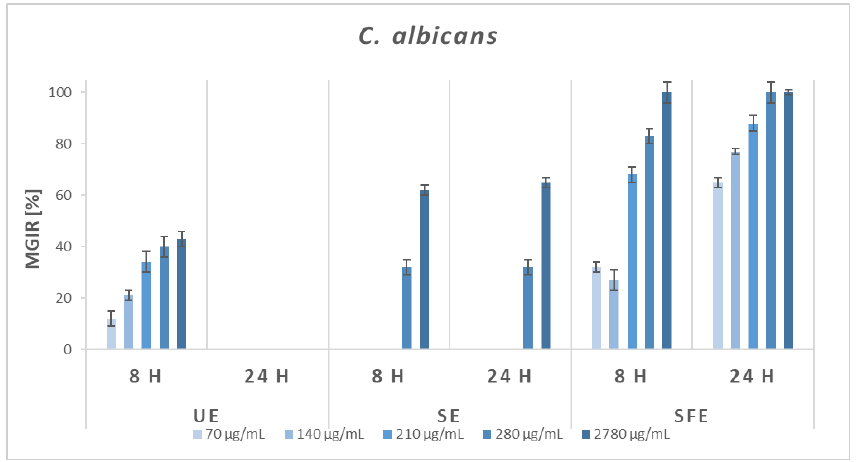
Figure 6. Microbial growth-inhibition rates (MGIRs) for AS extracts obtained by ultrasonic extraction (UE; solvent H 2 O), Soxhlet extraction (SE; solvent EtOH), and supercritical fluid extraction (SFE; solvent scCO 2 , co-solvent EtOH) using 70, 140, 210, 280, and 2780 µ g sample per mL of C. albicans suspension.